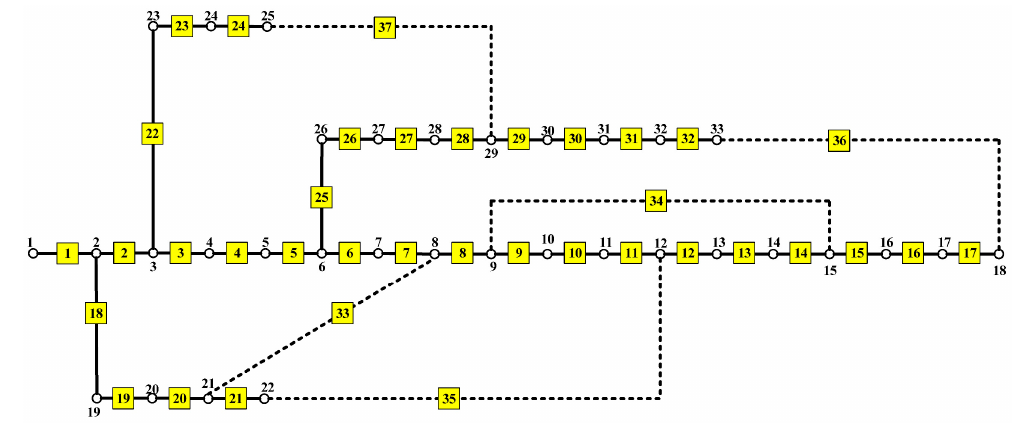
Figure 3. IEEE 33-node distribution system.